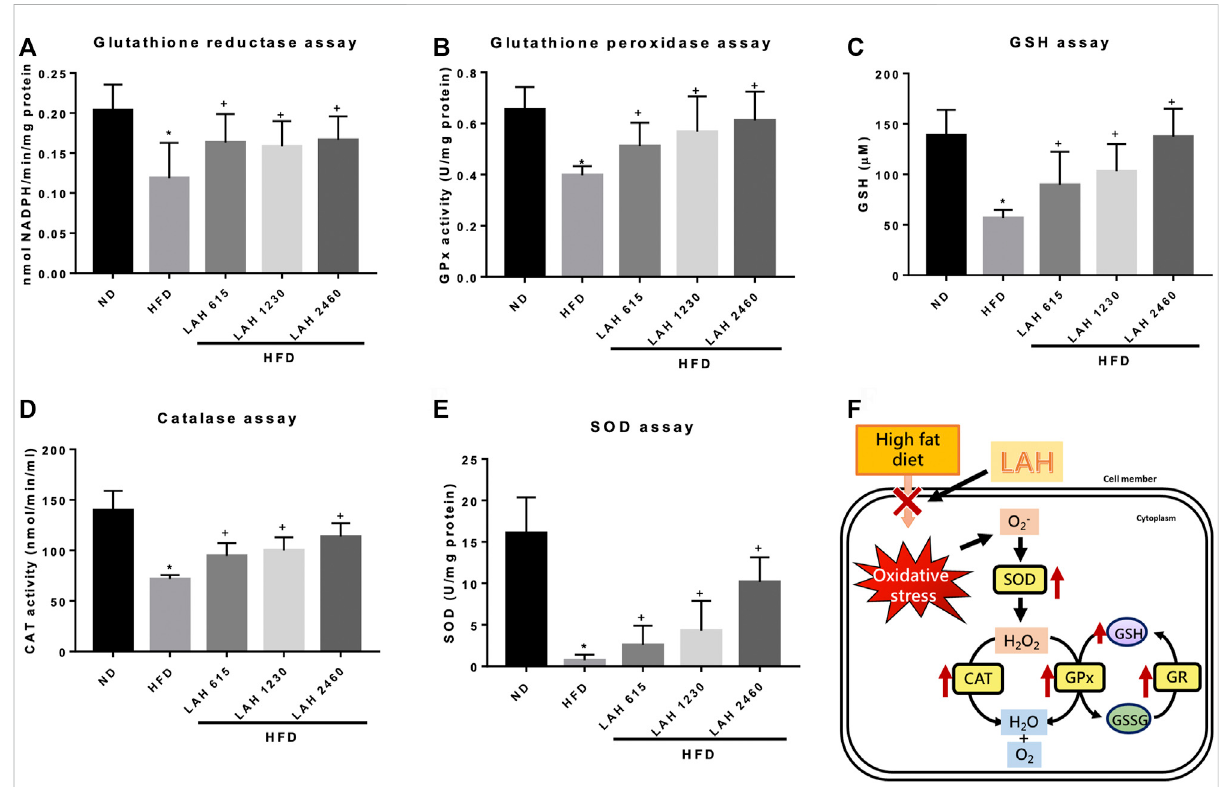
FIGURE 8 LAH attenuates hepatic oxidative stress and enhances antioxidant enzyme activity in HFD-mice. Levels of (A) Glutathione reductase (GR), (B) Glutathione peroxidase (GPx), (C) GSH, (D) CAT, and (E) SOD in liver tissue. (F) A schematic illustration of the antioxidant effect of LAH. Values are expressed as mean ± SD ( n = 10/group). * p < 0.05 compared with ND group. + p < 0.05 compared with HFD